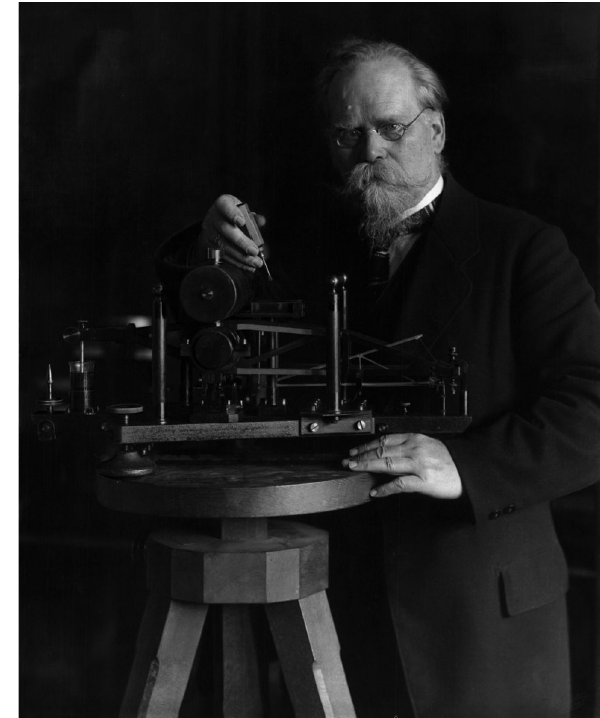
Figure 1. Emil Wiechert (1861–1928). Undated picture (taken